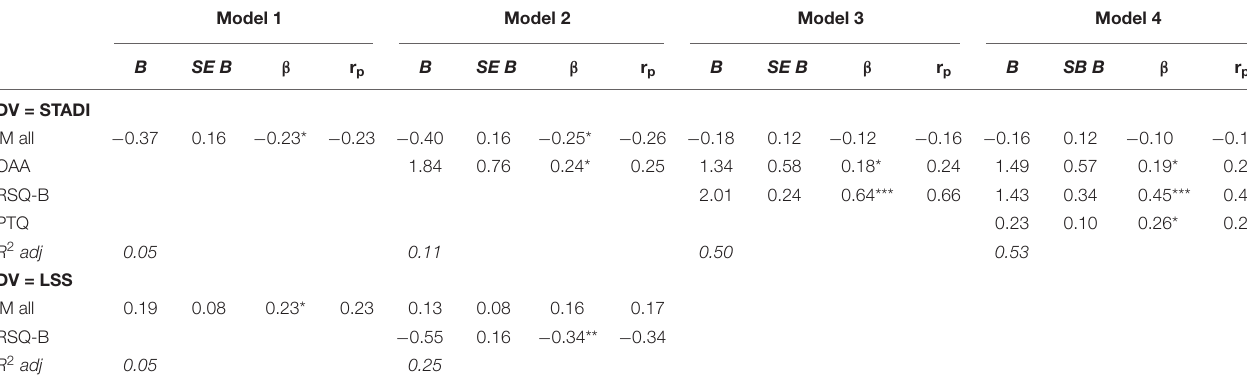
TABLE 4 | Hierarchical multiple regressions of narrative measures and trait rumination on trait depression and anxiety and on life